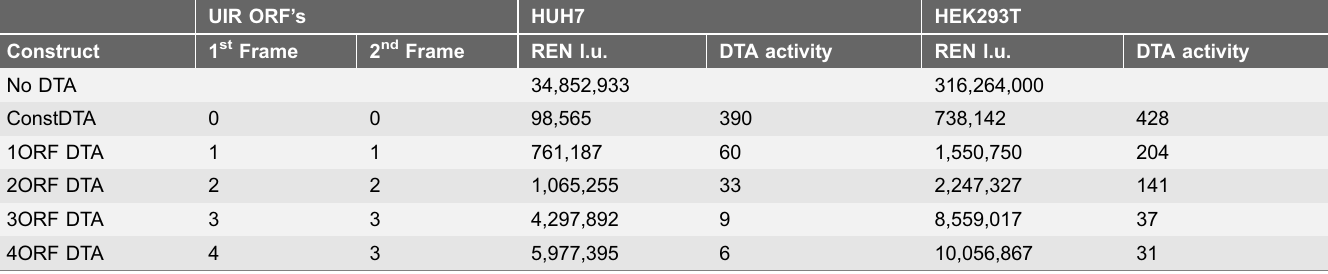
Table 1. The effect of various UIR configurations on the activity of the DTA transgene. UIR ORF’s HUH7 HEK293T